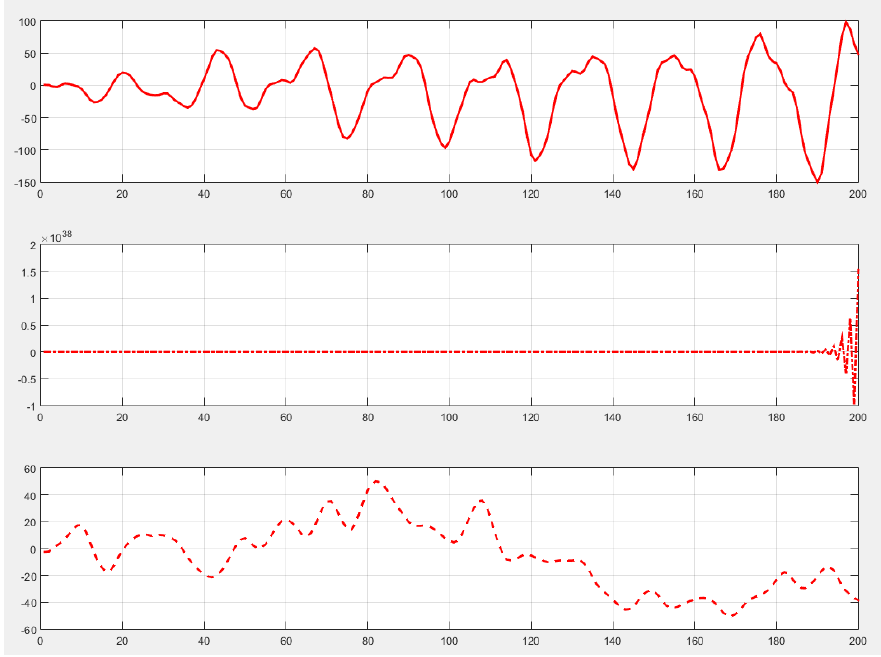
Fig. 5 Time domain presentation of signals from CF based on phrase No. 1.